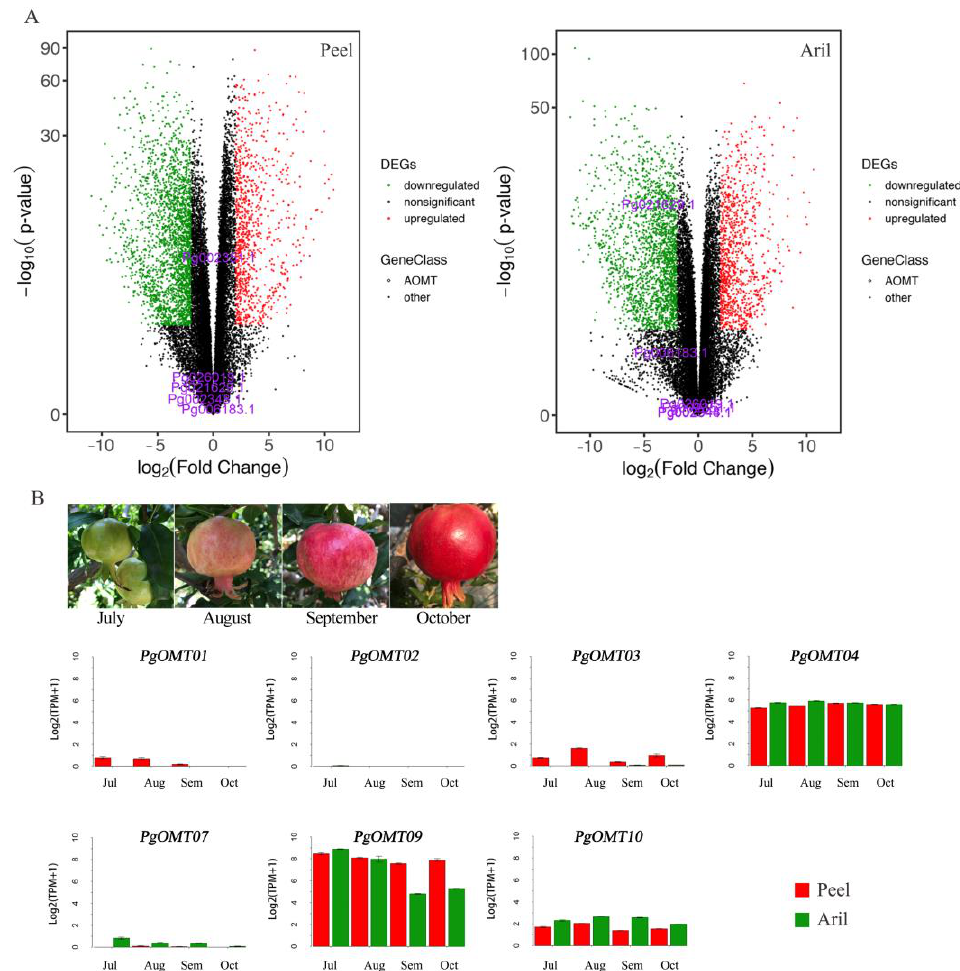
Figure 3. Expression pattern of PgAOMTs. ( A ) Up-regulated (red point) and down-regulated (blue point) differently expressed AOMTs during peel and aril development. ( B ) Expression of PgAOMTs in peel and aril during development.